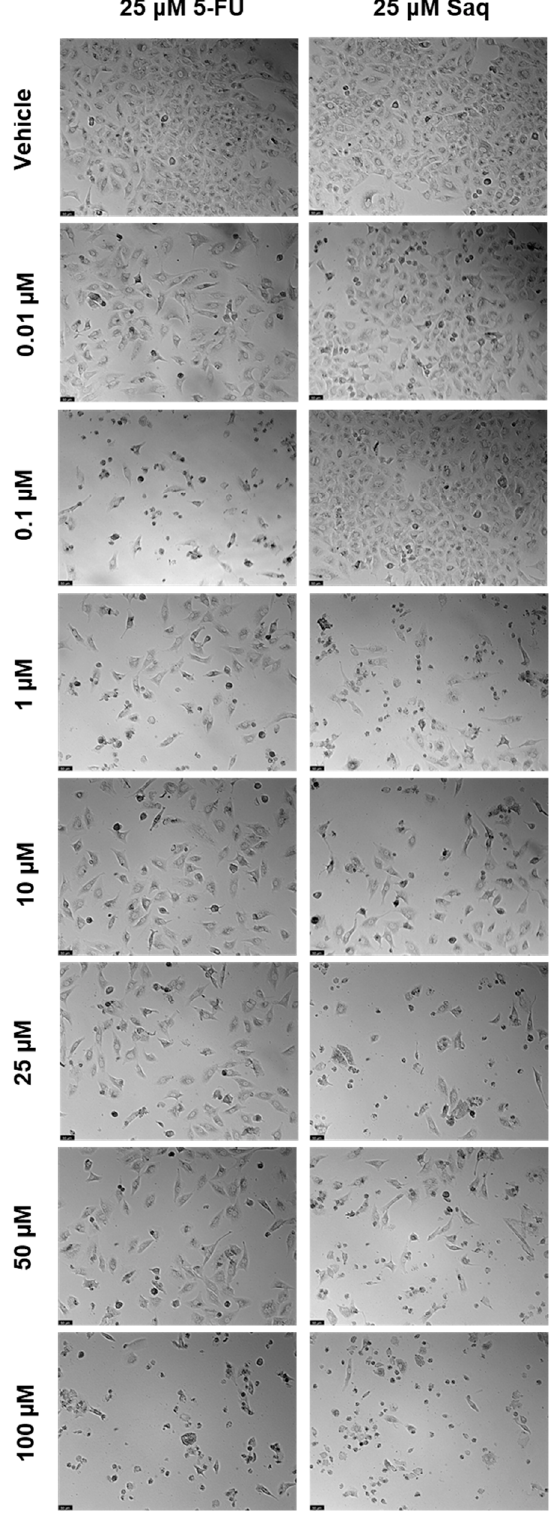
Figure 18. Morphological evaluation of A549 after exposure to combinations of 25 μ M of 5-FU with increasing concentrations of saquinavir (0.01–100 μ M) or 25 μ M of saquinavir with increasing concentrations of 5-FU (0.01–100 µ M) for 48 h. Both drugs were added at the same time. Control cells were treated with the vehicle (0.01% DMSO). These images are representative of three independent experiments. The scale bar is 200 μ M.